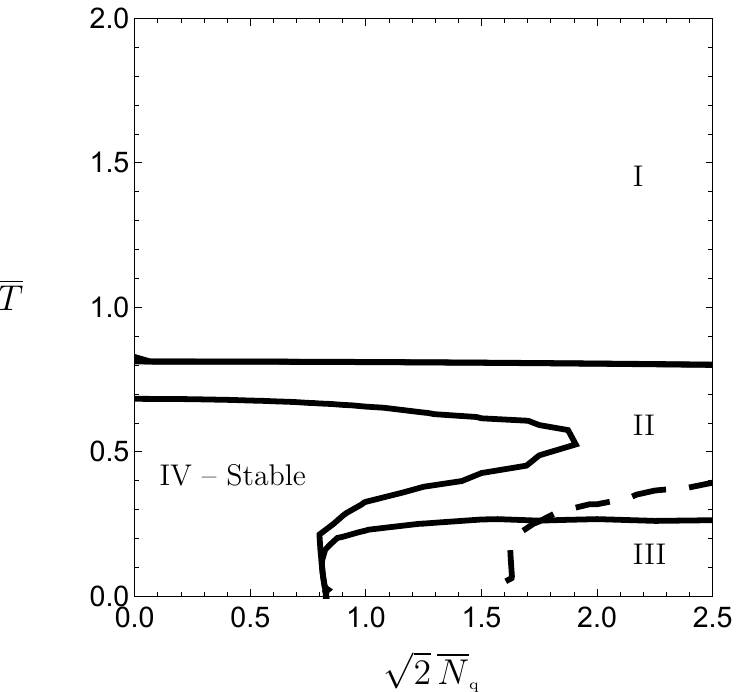
Figure 2. Phase diagram of the system as a function of temperature and charge density. The dimensionless quantities N and T are de(cid:12)ned in (2.60) and (3.8) , respectively. Labels I, II, q etc. refer to regions separated by continuous curves. Regions II and III split into two subregions separated by the dashed curve. The only stable region is Region IV. At points inside the dashed curve (bottom-right corner of the diagram) the pressure is lower than that of the neutral phase at the same